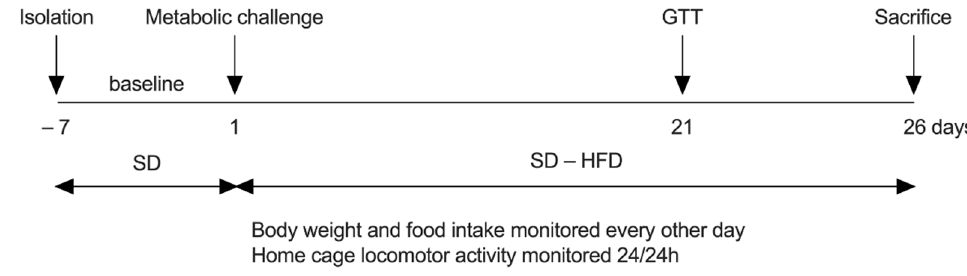
Figure 8. Experimental outline.